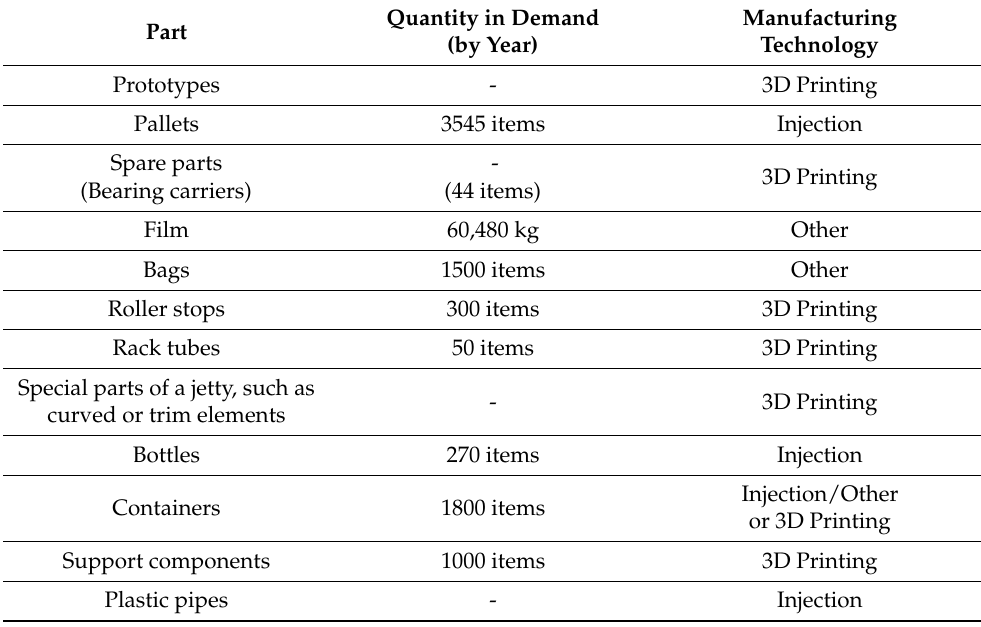
Table 3. Summary of the commercial products identified for replacement by green (recycled) ones. Quantity in Demand Part (by Year)